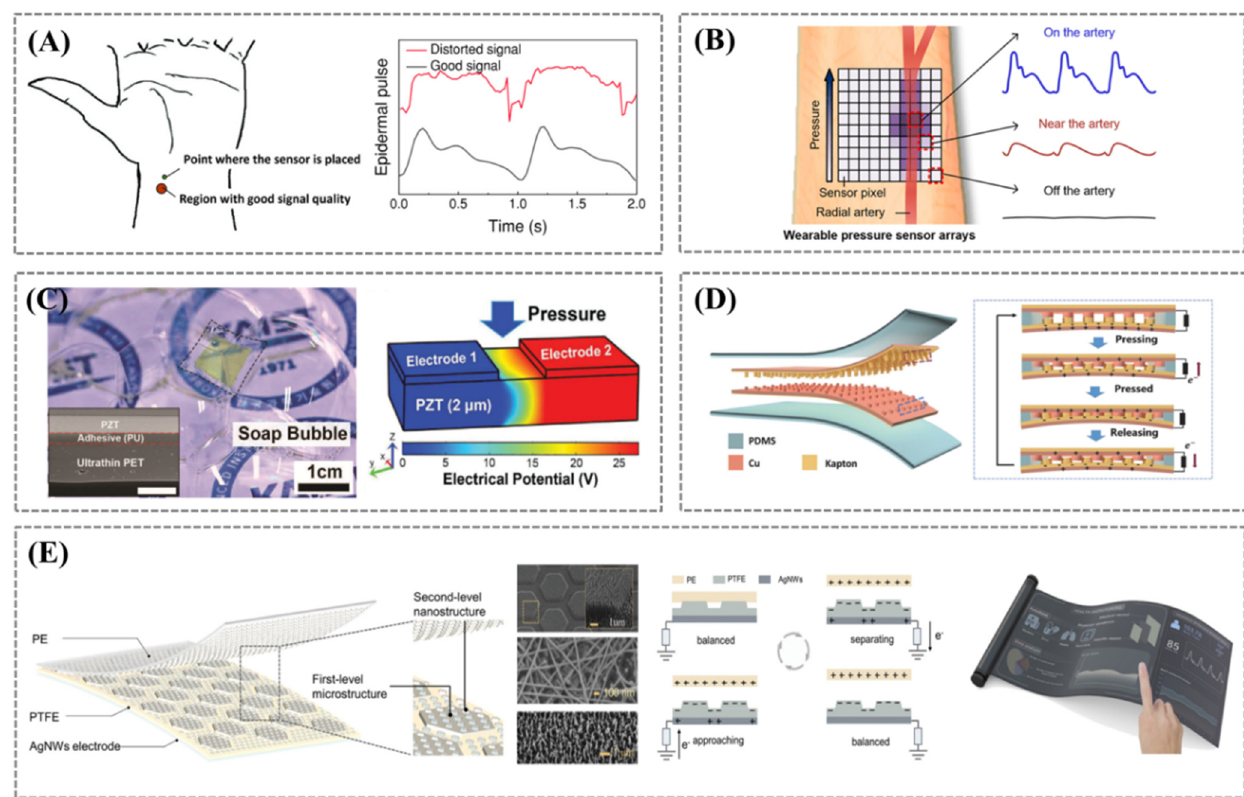
Figure 3. ( A ) Comparison of normal and distorted signals due to sensor misalignment in epidermal pulse measurement. Reprinted/adapted with permission from Ref. [38]. ( B ) Sensor arrays for locating arteries and acquiring accurate pulse waveforms. Reprinted/adapted with permission from Ref. [39]. ( C ) Ultrathin flexible PZT pressure sensor and the piezoelectric potential distribution, the inset indicates a cross-sectional SEM image (scale bar, 5 μ m). Reprinted/adapted with permission from Ref. [40]. ( D ) Schematic diagram of self-powered ultrasensitive pulse sensor (SUPS) and its working principle. Reprinted/adapted with permission from Ref. [41]. ( E ) Schematic illustration of the ultrathin and flexible sensor (UFS) and its application for finger-touching measurement in single-electrode mode. Reprinted/adapted with permission from Ref. [42].